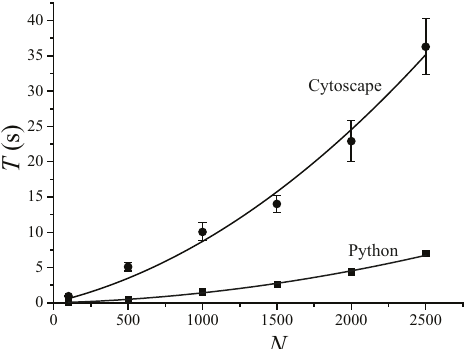
Figure 1. Average computation time (T) of MSClustering in Cytoscape and in Python for the hierar- chical clustering of a network of N elements on an Intel Core i9-9900KF CPU desktop computer. The solid lines show the curve of best fit.